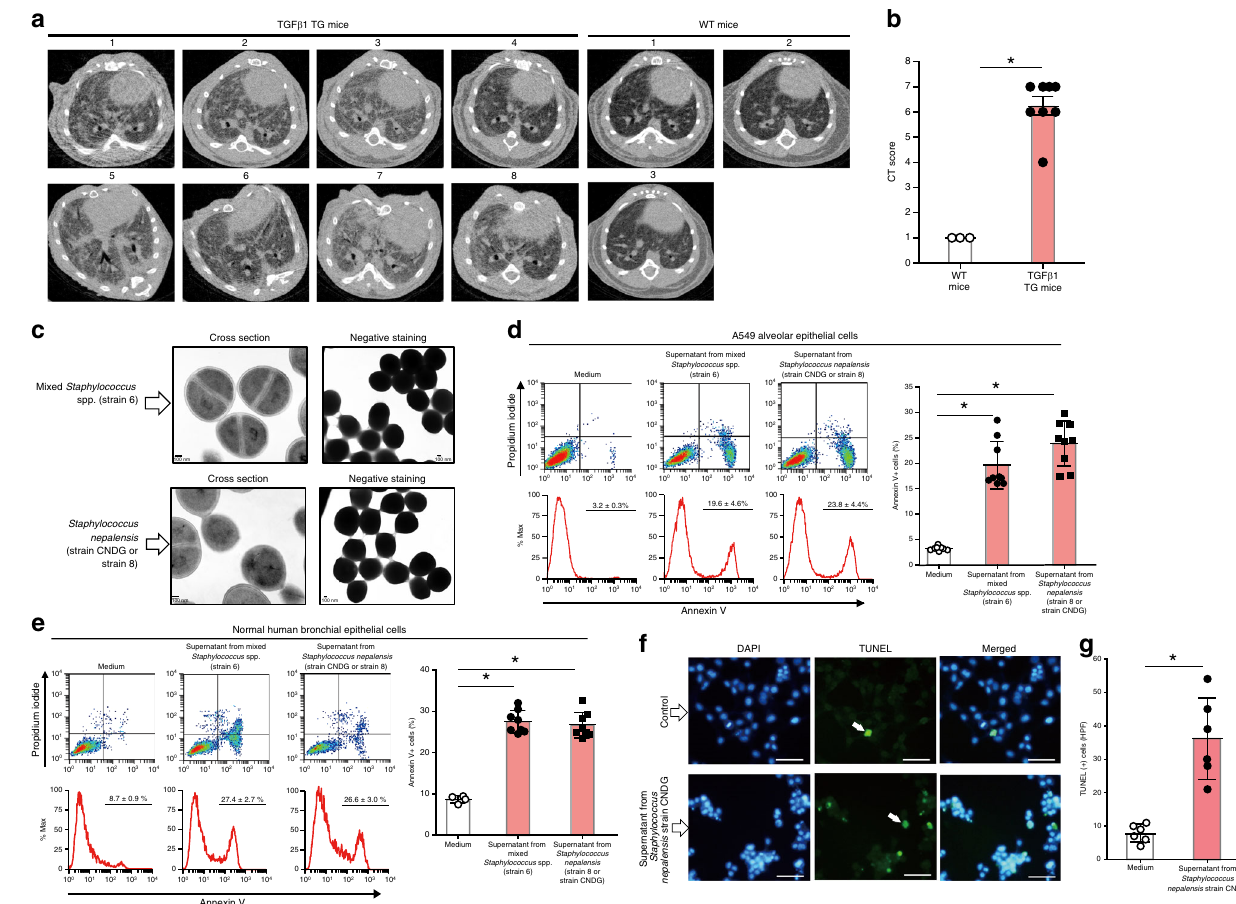
Fig. 2 Growth of bacteria from fi brotic lung tissue cultured under hypersaline conditions and apoptosis induced by their culture supernatants. a , b Computed tomography (CT) and CT fi brosis scoring of wild-type (WT) mice ( n = 3) and TGF β 1 transgenic (TG) mice ( n = 8). Bars indicate the means ± standard error of the means. Statistical analysis by two-tailed Wilcoxon signed rank test. * p = 0.01. c Fibrotic lung tissues excised under sterile conditions from wild-type ( n = 3) and TGF β 1 transgenic ( n = 8) mice were cultured in hypersaline culture media for 48 h. Analysis of bacterial colonies by transmission electron microscope. Scale bars indicate 100 nm. d Flow cytometry analysis of A549 alveolar epithelal cells cultured for 48 h in DMEM medium containing 1/10 diluted spent culture supernatant of the mixture of Staphylococcus spp. (strain 6; n = 9), Staphylococcus nepalensis strain CNDG ( n = 9), or control medium ( n = 9). Bars indicate the means ± S.D. Statistical analysis by two-tailed Mann – Whitney U test. * p < 0.0001. e Flow cytometry analysis of normal human bronchial epithelial cells cultured for 48 h in DMEM medium containing 1/10 diluted spent culture supernatant of the mixture of Staphylococcus spp. (strain 6; n = 8), Staphylococcus nepalensis strain CNDG ( n = 8), or control medium ( n = 4). Bars indicate the means ± S.D. Statistical analysis by two-tailed Mann – Whitney U test. * p < 0.005. f , g TUNEL assay was performed as described under methods after culturing A549 alveolar epithelial cells in the presence of medium ( n = 6) or supernatant of Staphylococcus nepalensis strain CNDG ( n = 6). Scale bars indicate 20 µ m. Bars indicate the means ± S.D. Statistical analysis by two-tailed Mann – Whitney U test. * p < 0.01. Abbreviations are de fi ned as HPF, high-power fi eld; TUNEL, terminal deoxynucleotidyl transferase dUTP nick end labeling; DAPI, 4 ′ ,6-diamidino-2-phenylindole. The source data underlying 2 b , d , e , g are provided in the Source Data fi